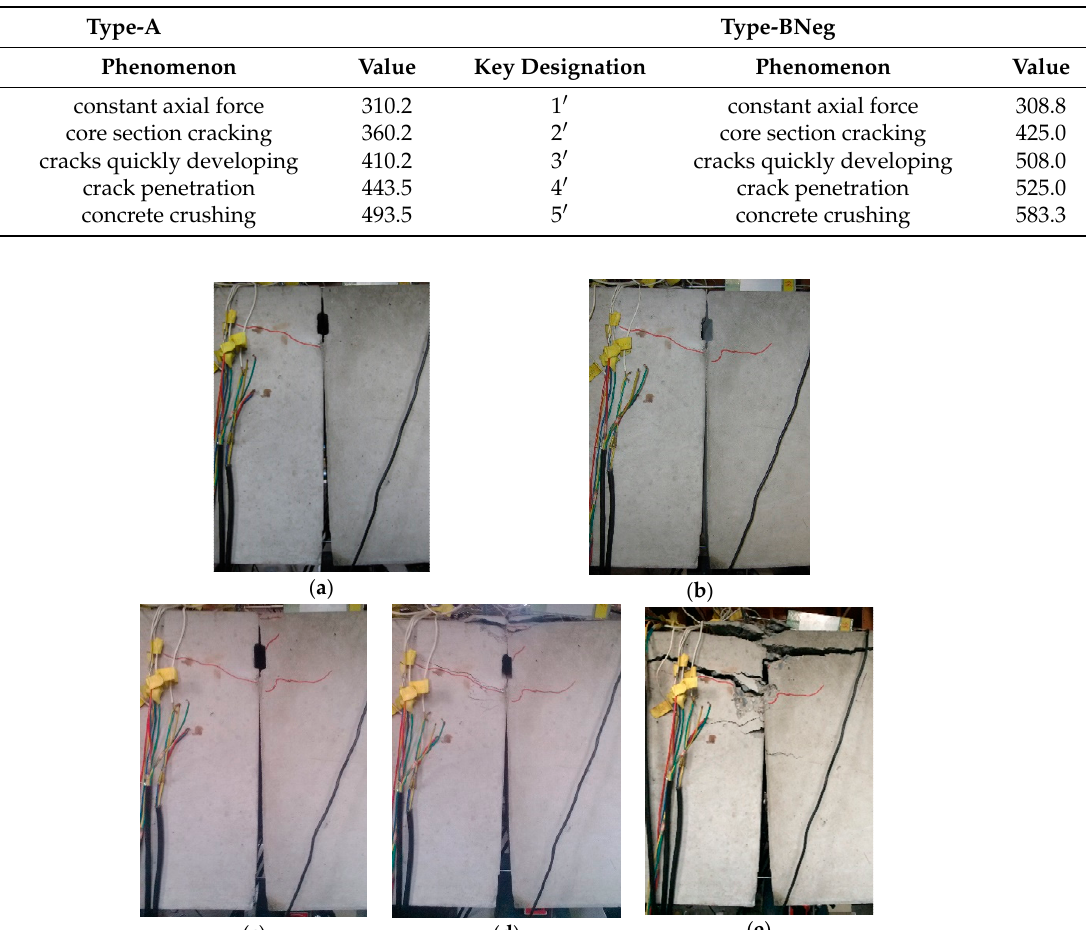
Table 3. Key moments during the damage processes in negative cases (unit: kN · m/m).